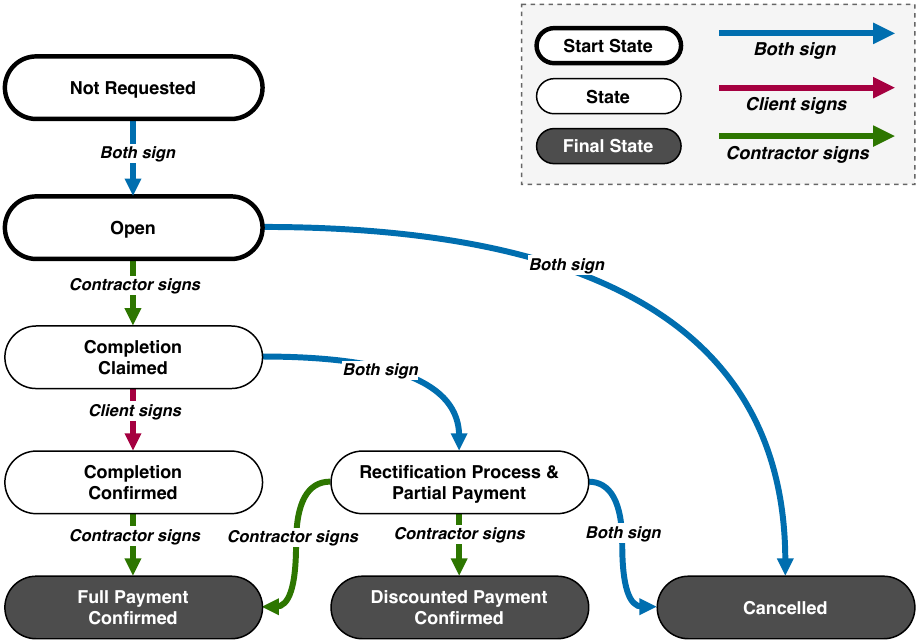
Figure 8. State machine billing unit